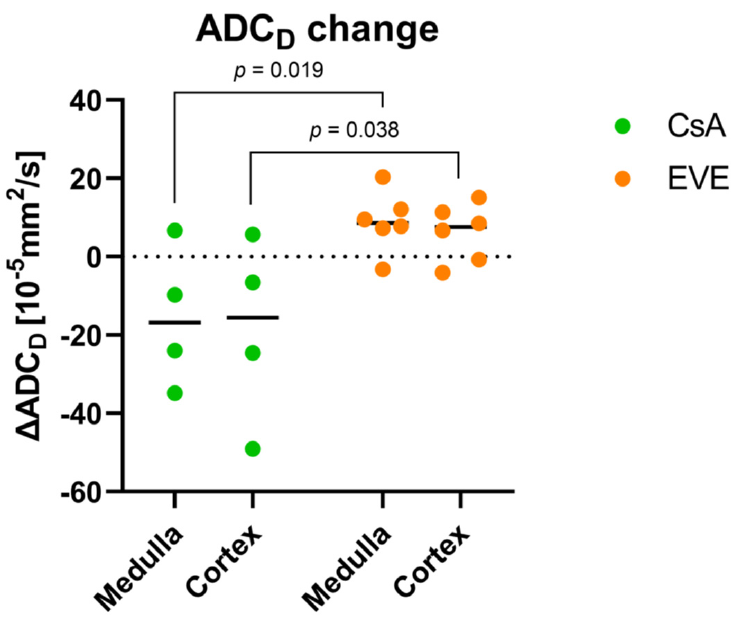
Figure 4. Change in DWI-derived diffusion coefficient. Change in diffusion coefficient ADC D from month 4.5 to month 12. p -value calculated according to Mann–Whitney U-test. Table 3. DWI-derived pure diffusion coefficient according to medication group and time-point.